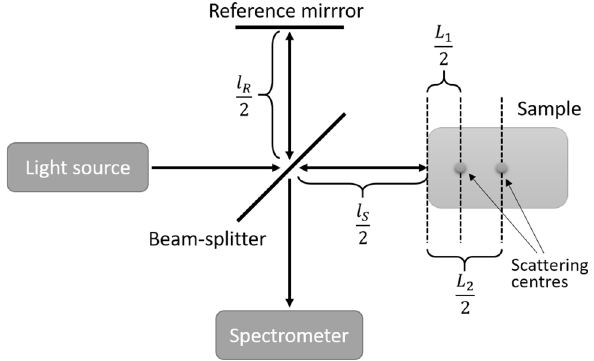
Figure 1. A schematic drawing of an interferometer with path lengths used for